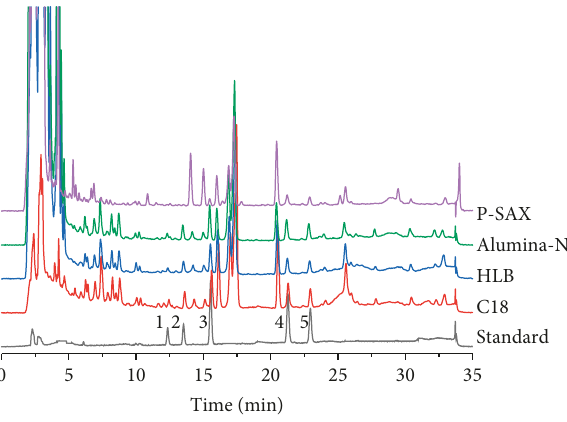
Figure 6: Comparison of HPLC chromatograms obtained using different SPE methods for analysis five triterpene acids in LDC. (1) 3-O- Acetyl 16 α -hydroxytrametenolic acid, (2) dehydropachymic acid, (3) pachymic acid, (4) trametenolic acid, and (5) dehydrotrametenolic acid.